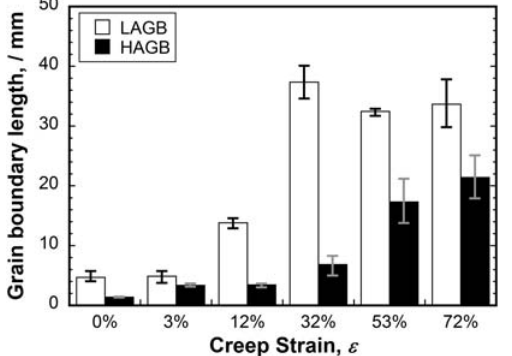
Figure 8: Grain boundary length of LAGBs and HAGBs in the Mo ss in the MoSiBTiC alloy crept at 1,500°C and 137 MPa with various creep strains.